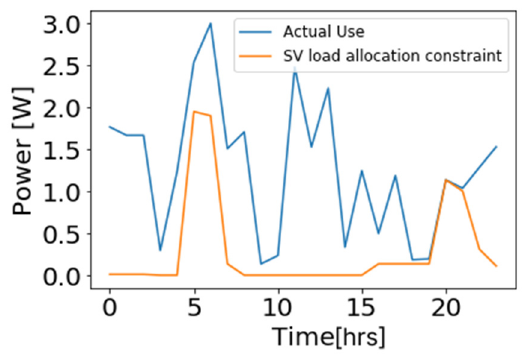
Figure 7. Power usage by each device with the proposed SV load allocations vs. real usage according to the REDD [31] database.